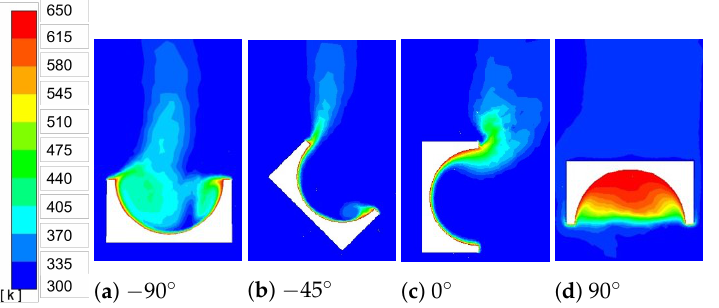
Figure 19. Section temperature contour views of the hemispherical cavity receiver. Cavity: isothermal copper at 650 K; external receiver surface: isothermal at 300 K, adiabatic; body: incompressible ideal gas, ambient air at 300